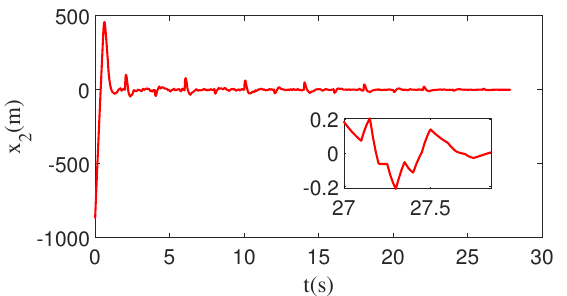
Figure 20. The change in ZEM with white noise and square wave maneuver.